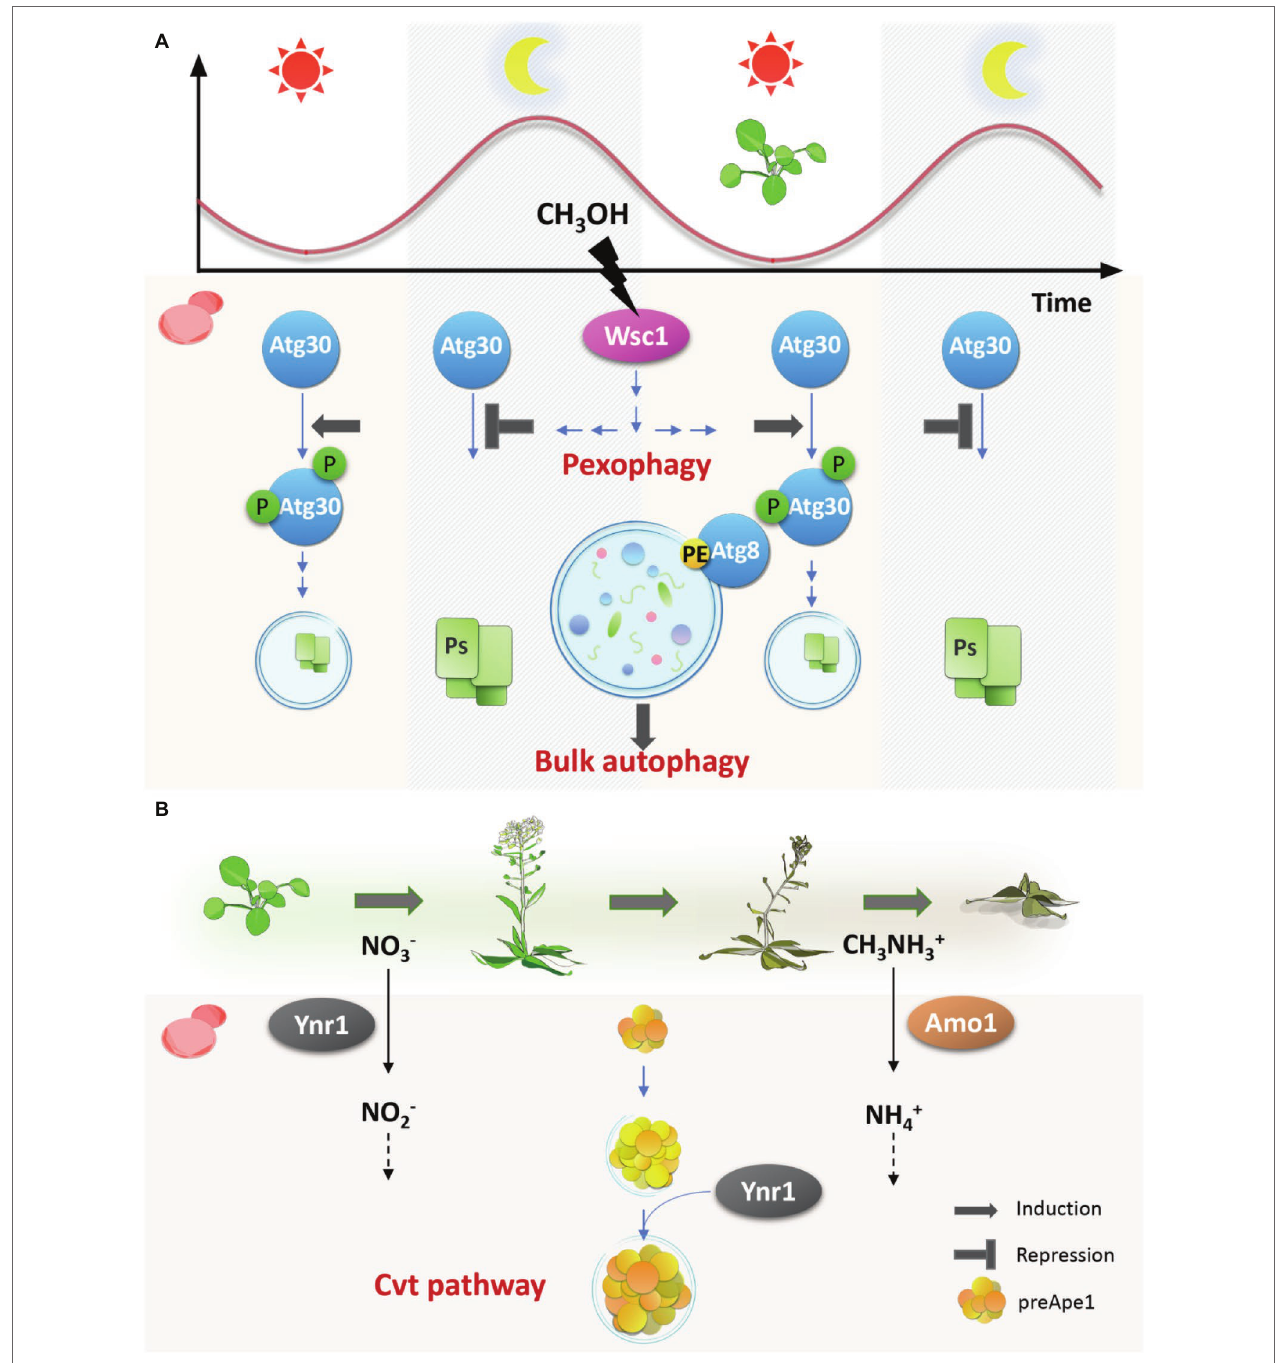
FIGURE 1 | Schematic representation of the microbial regulation of autophagy in the ever-changing phyllosphere environment. Phyllosphere microbes make the best use of the autophagy mechanism to adapt to the host plant changes during both the daily cycle (A) and the host plant life cycle (B) . On young growing leaves, methanol (CH 3 OH) concentration is low in the light period and high in the dark and oscillates diurnally. As plants age, the available nitrogen source changes from nitrate (NO 3 − ) to methylamine (CH 3 NH 3 + ). To respond to these changes, phyllosphere microbes employ the autophagy mechanism. On plant leaves, bulk autophagy, chased by Atg8, is always active, whereas some selective autophagy pathways are tightly regulated. Pexophagy, monitored by Atg30, is negatively regulated in a Wsc1-dependent manner. Wsc1 senses the external methanol at the cell surface and transmits signals to the downstream factors. Only when the local methanol concentration is low, pexophagy is induced through the phosphorylation of Atg30. Cvt pathway, responsible for transporting vacuolar hydrolases like Ape1, which is synthesized as a precursor form (preApe1), is constitutively active in the phyllosphere. However, it recruits Ynr1, yeast nitrate reductase, only on aged leaves where methylamine is the major nitrogen source, and therefore, Amo1, but not Ynr1, is necessary. Ps: Peroxisomes, PE: Phosphatidylethanolamine, and P: